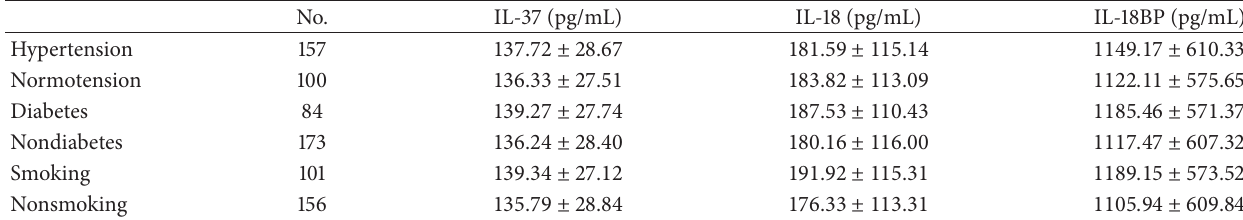
Table 4: Plasma biomarker levels in traditional risk factors.